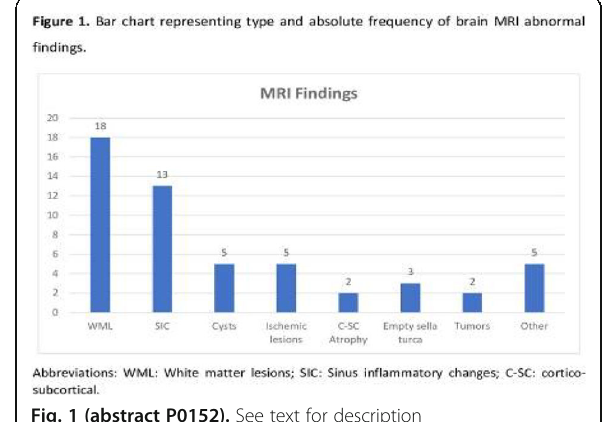
Fig. 1 (abstract P0152). See text for description